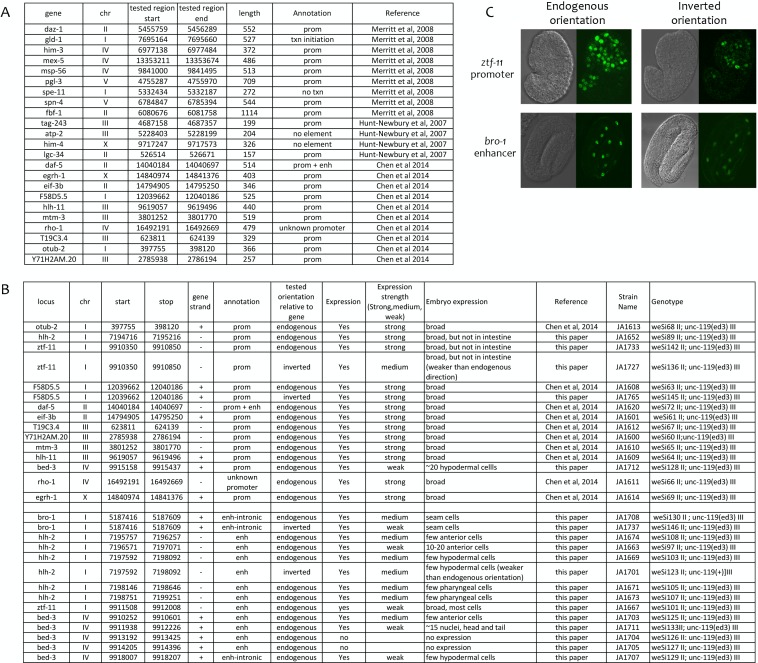
Transgenic tests of annotated promoters and enhancers for promoter activity.(A) Comparison of annotations to 23 elements previously shown to function as promoters in transgenic assays (Merritt et al., 2008; Hunt-Newbury et al., 2007; Chen et al., 2014). (B) Indicated elements were fused to his-58::gfp (see Materials and methods) and the resulting transgenic strains tested for GFP expression in embryos. Elements were cloned in the endogenous orientation relative to their associated gene or in inverted orientation, as indicated. In expression strength column, ‘strong’ and ‘medium’ indicate high and low level of GFP visible in live embryos; ‘weak’ indicates expression only visible by immunofluorescence. (C) Examples of transgene expression. Shown is expression driven by the ztf-11 promoter and the bro-1 enhancer in both orientations; DIC image on left, HIS-58-GFP on right.